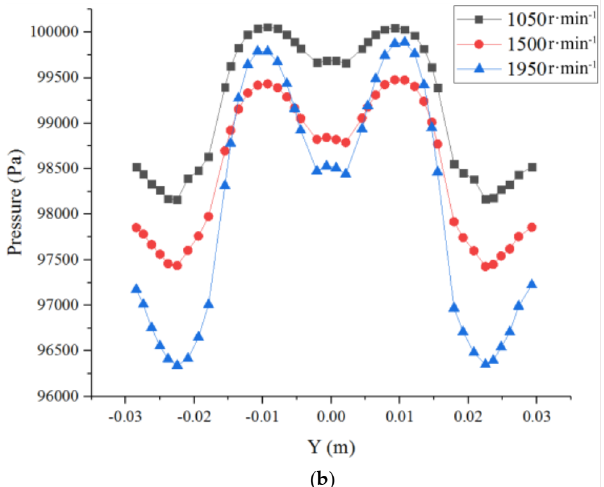
Figure 16. ( a ) The pressure distribution along X direction at various rotation speeds. ( b ) The pressure distribution along the Y direction at various rotation